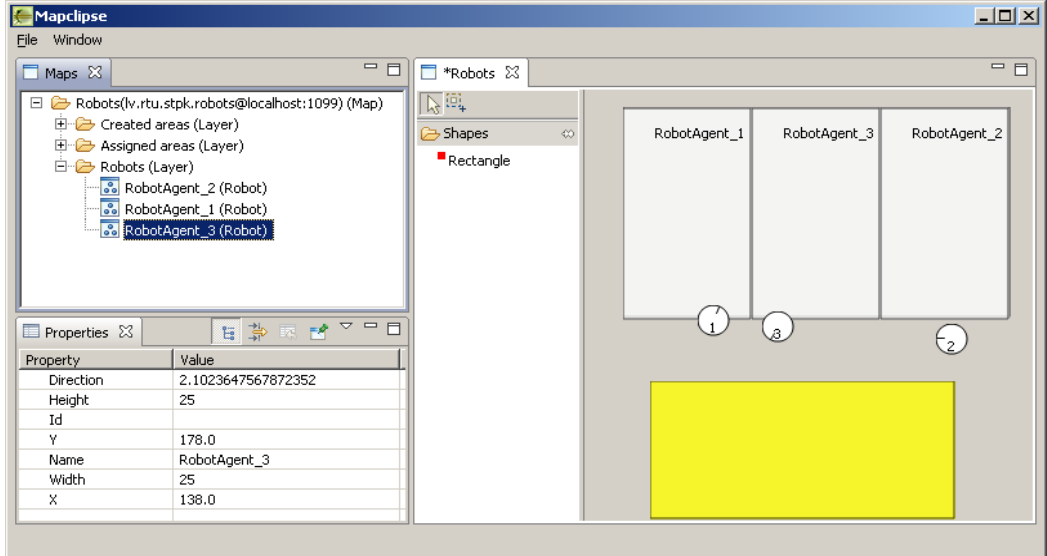
Fig. 5. Mapclipse GUI with vacuum cleaner robot map